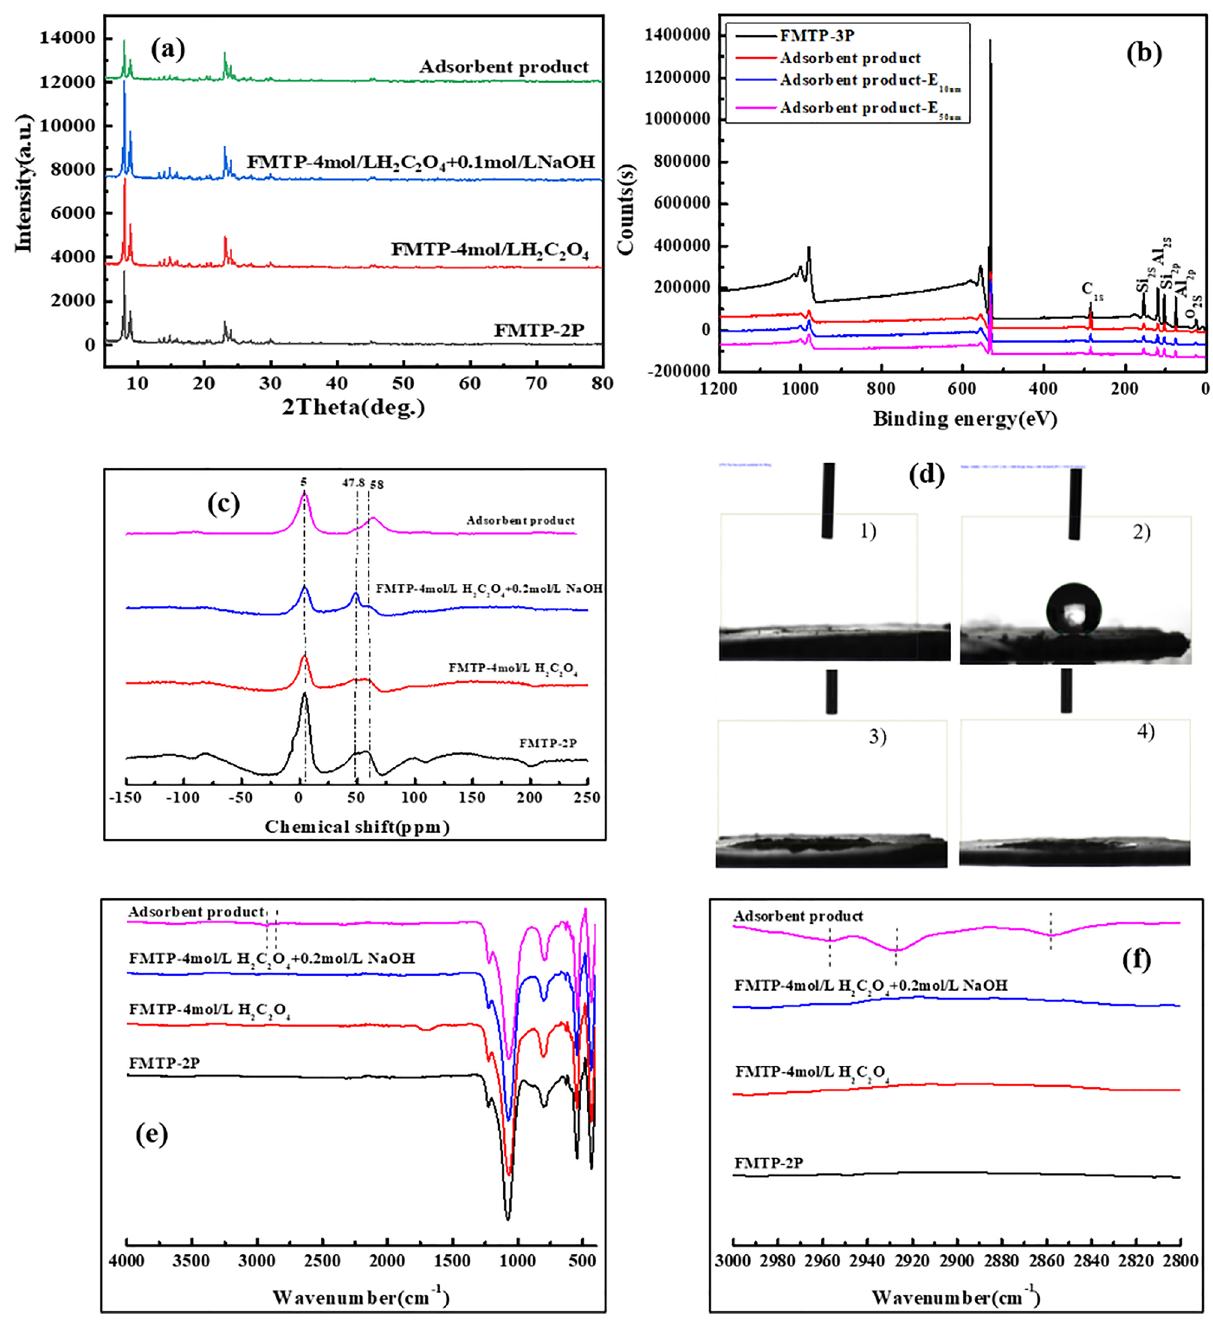
Figure 2. XRD of adsorbent products ( a ); XPS diagram of adsorbent products ( b ); 27 Al MAS NMR spectra of hydrophobic adsorbent product ( c ); Static CA of hydrophobic adsorbent products ( d ); FMTP-OTS without droplets (1), FMTP-OTS with water droplets (2), FMTP-OTS with p -xylene droplets (3) and FMTP-OTS with n -hexane droplets (4); Infrared spectrum of adsorbent products wavenumber from 500 to 4000 cm −1 ( e ), infrared spectrum of adsorbent products wavenumber from 2800 to 3000 cm −1 ( f